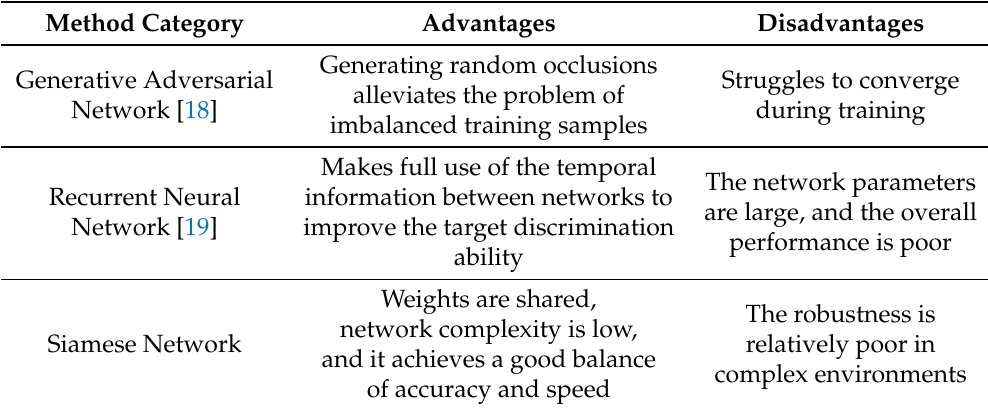
Table 1. Summary of object tracking algorithms based on deep